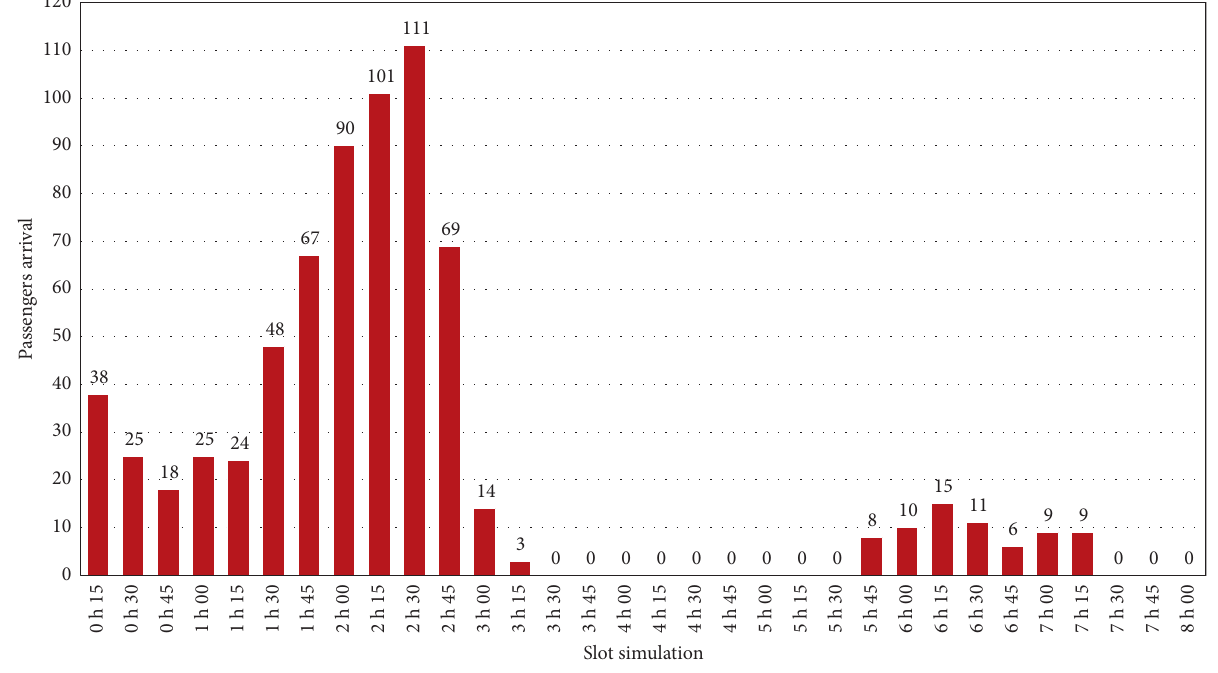
Figure 6: Passengers’ arrival in the four cat- lug